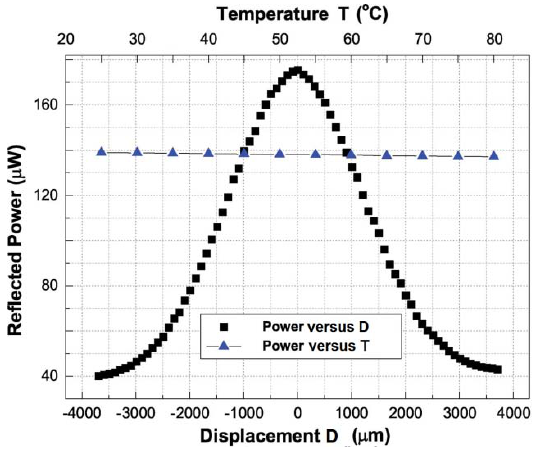
Figure 4. Cascade of up-taper and chirped FBG (CFBG) [54]. Behavior of cladding mode power and core mode power versus displacement and cladding mode power versus temperature.